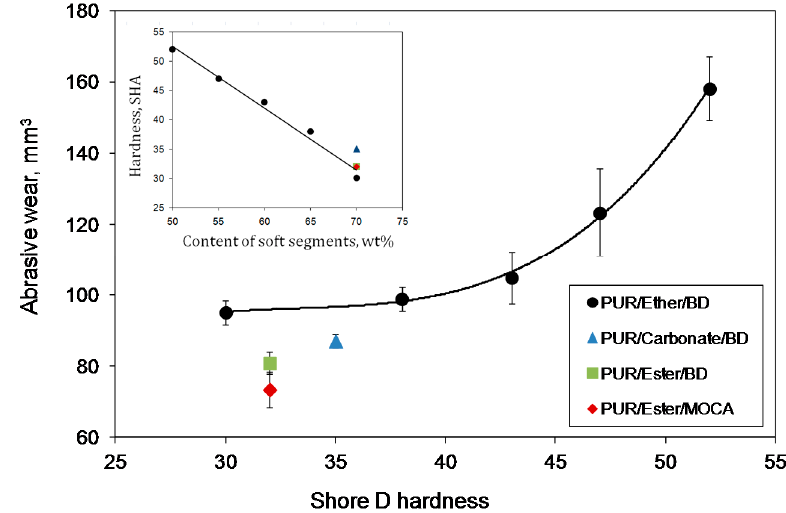
Figure 4. Abrasion wear of PUR versus their hardness.